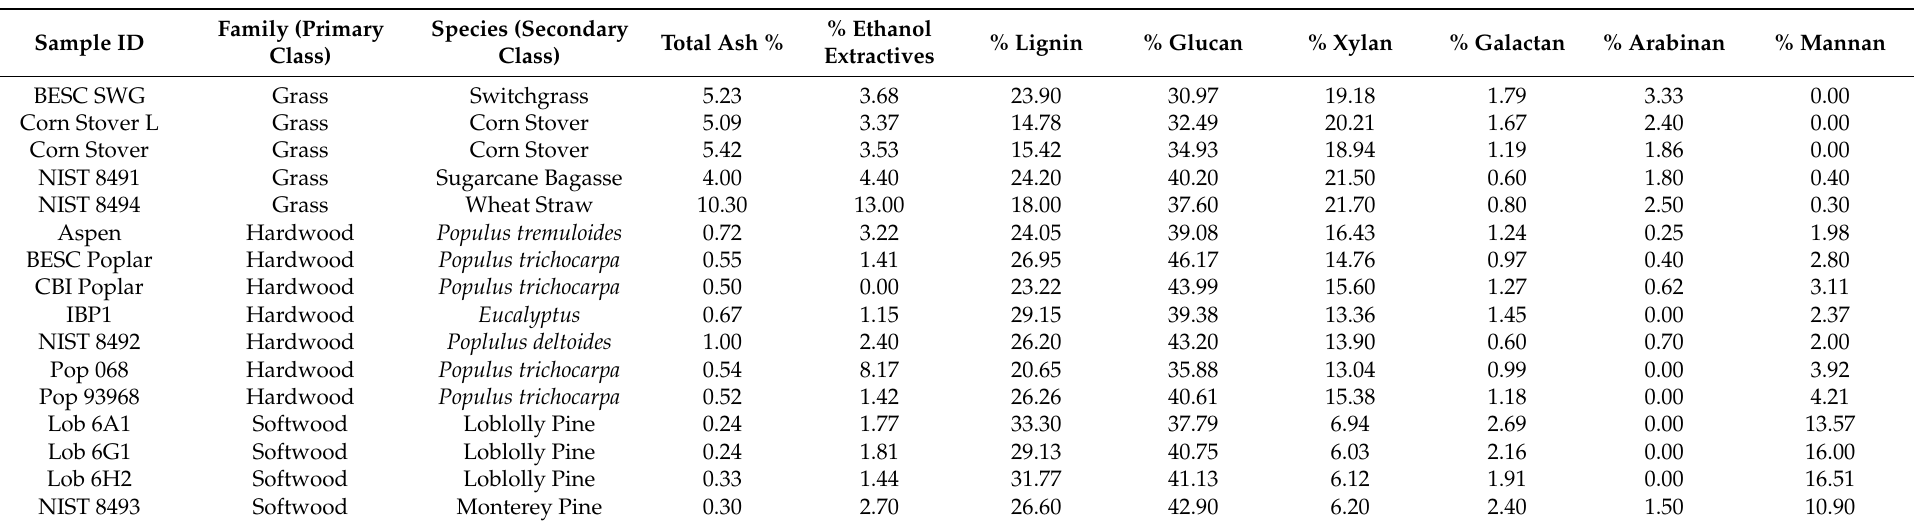
Table 8. Composition analysis of lignocellulosic biomass analyzed by